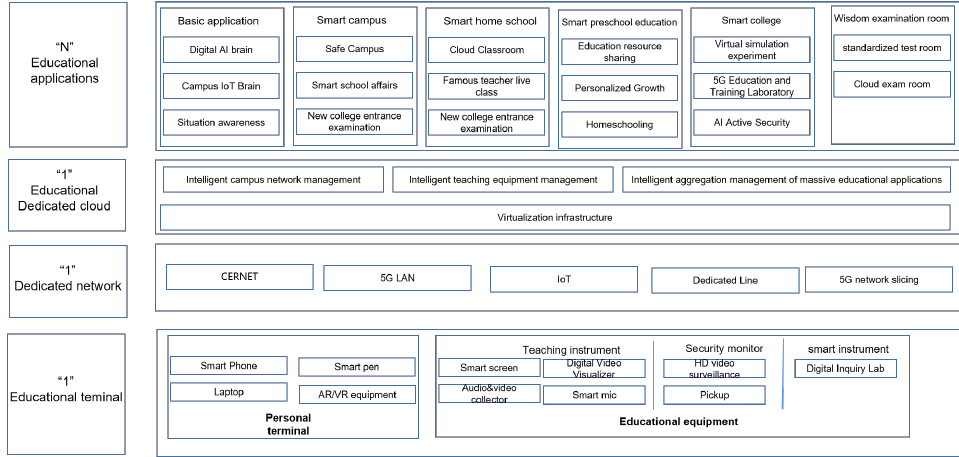
Figure 1. System architecture of smart educational